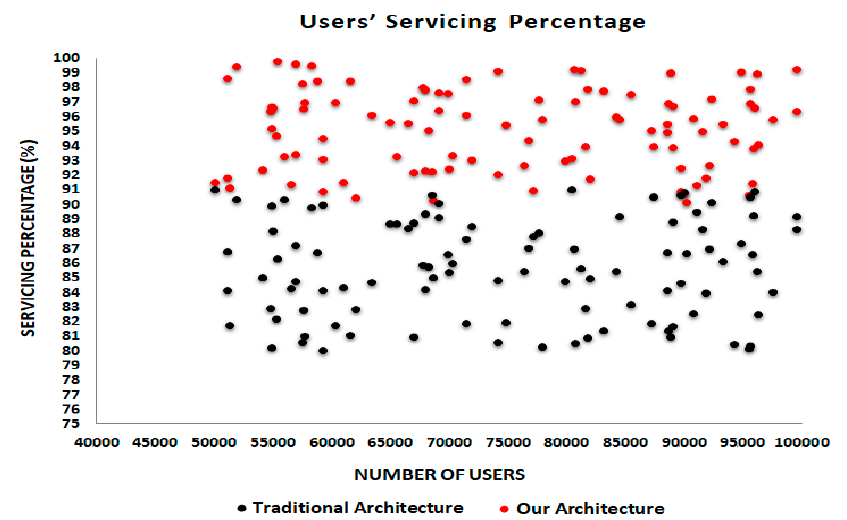
Figure 13. Percentages of served users.